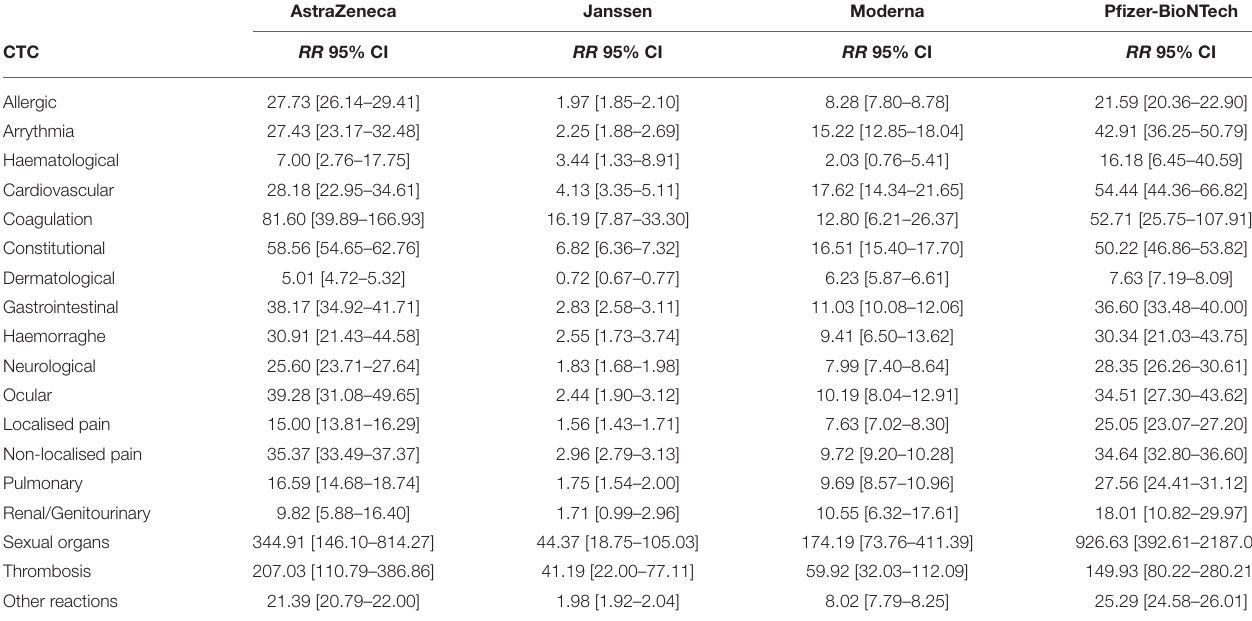
TABLE 2b | Vaccine-related relative risk estimates (RR) and 99% confidence intervals (CI) by Common Toxicity Criteria (CTC) in the EudraVigilance